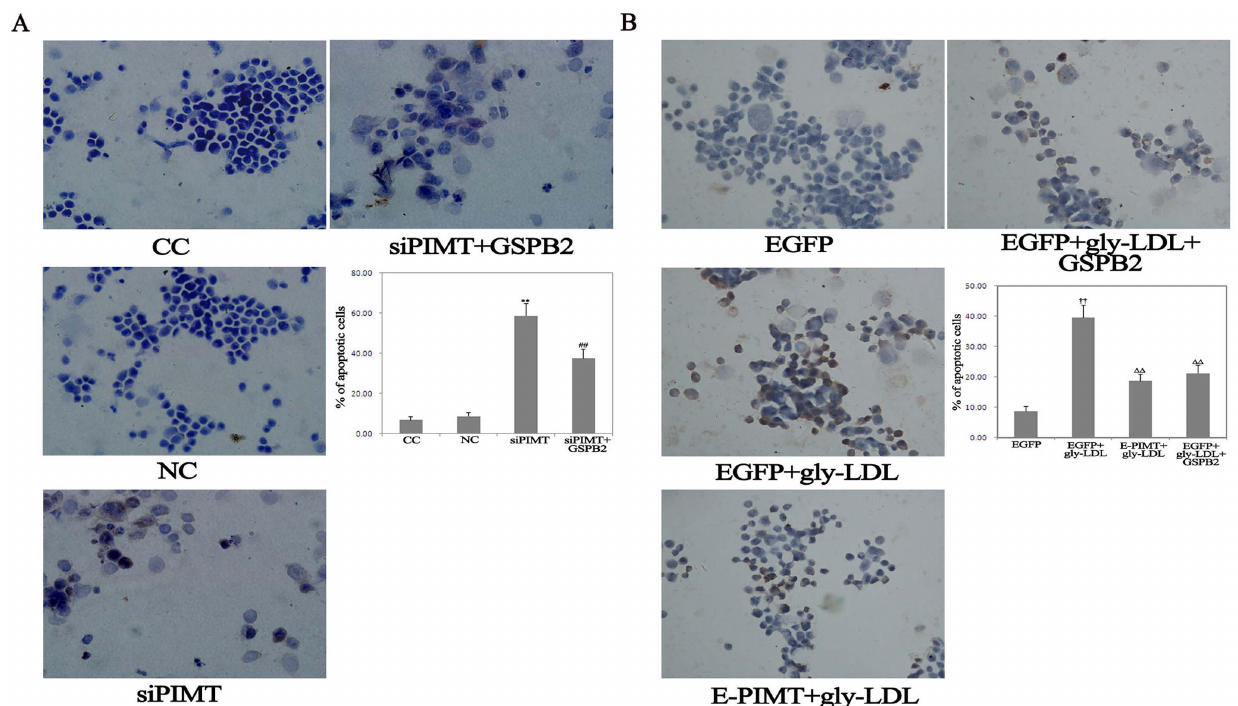
Figure 5. Effects of PIMT on cell apoptosis treated by gly-LDL with TUNEL assay ( 6 400). A: Effects of PIMT siRNA, GSPB2 on apoptosis in HUVEC. B: Effects of PIMT overexpression, GSPB2 on apoptosis in HUVEC treated by gly-LDL. The bar graph at the bottom shows the percentage of apoptotic cells. Results represent mean 6 SD of five independent experiments. * P , 0.05, ** P , 0.01 compared with NC group; # P , 0.05, ## P , 0.01 compared with siPIMT group. { P , 0.05, {{ P , 0.01 compared with EGFP group; D P , 0.05, DD P , 0.01 compared with EGFP + gly-LDL